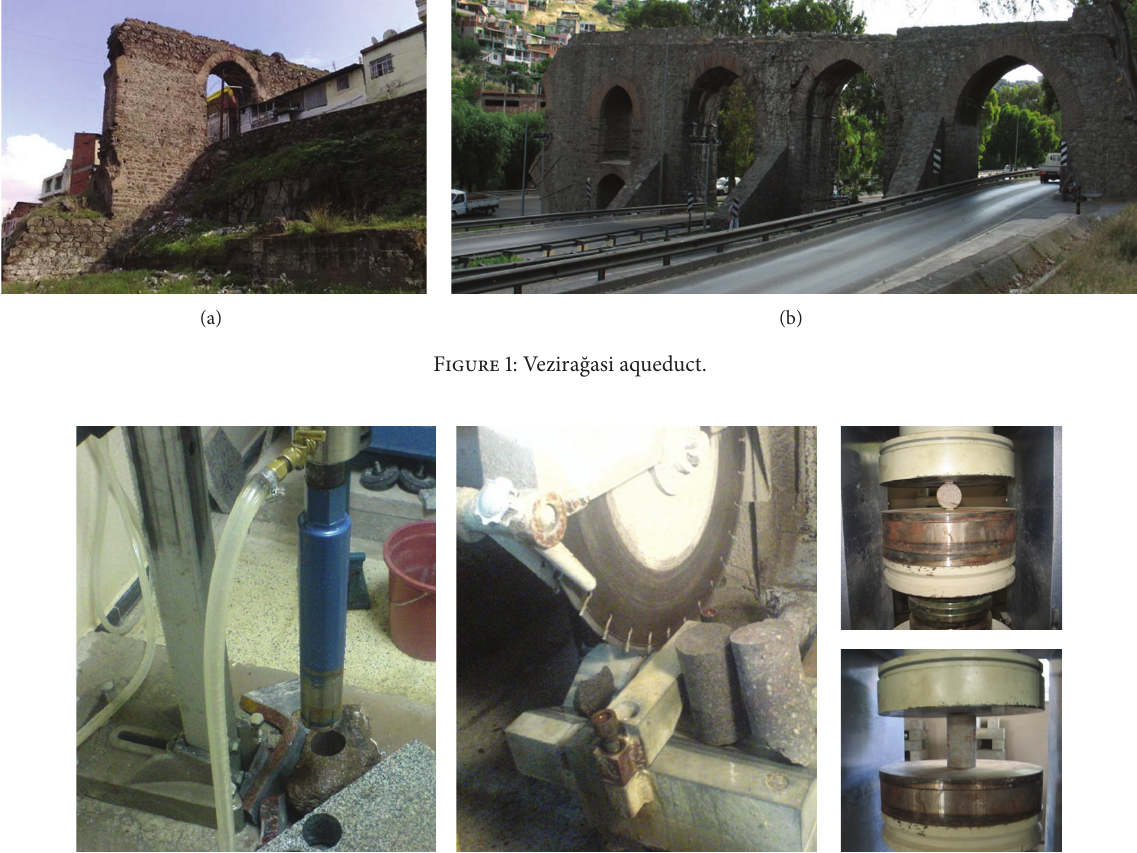
Figure 2: Drilling out core samples, cutting edges, uniaxial compression, and Brazilian